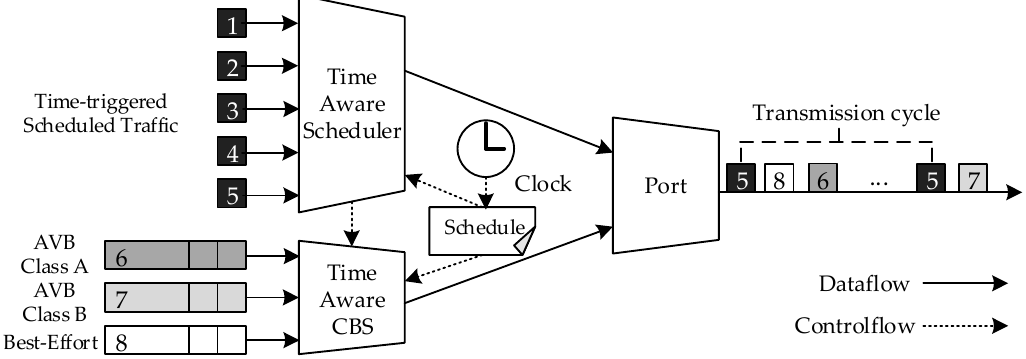
Figure 2. Time-aware scheduler and queuing structure in the in-vehicle network (IVN) nodes.